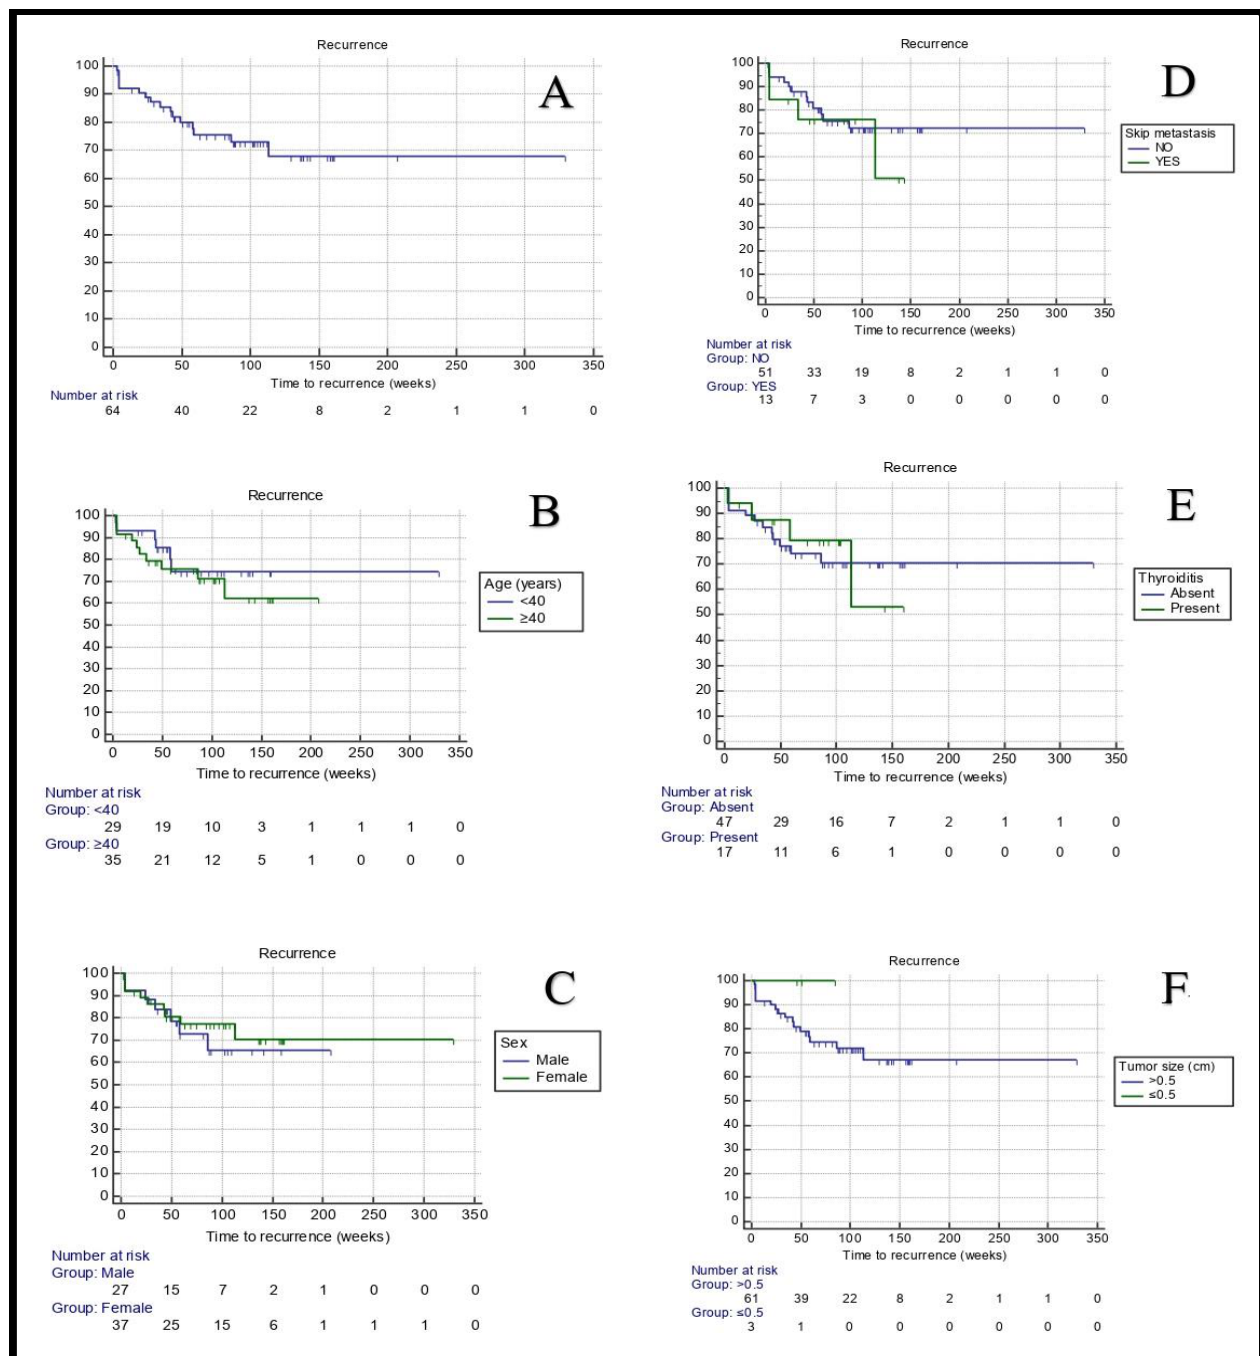
Figure 1: Time-to-recurrence (TTR) Kaplan-Meier Curves. 1A: TTR of all patients; 1B: TTR, age >40 years vs <40; 1C: TTR, males vs. females; 1D: TTR, skip metastasis vs. no skip metastasis; 1E: TTR, thyroiditis versus no thyroiditis; 1F: TTR, tumor size >0.5 cm vs. <0.5